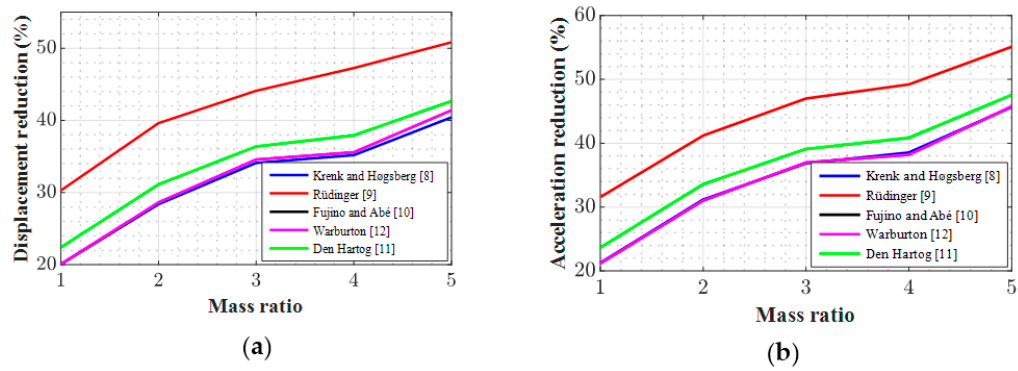
Figure 7. Comparison of the structural response for measuring the effectiveness of TMD: ( a ) displacement reduction; ( b ) acceleration reduction.